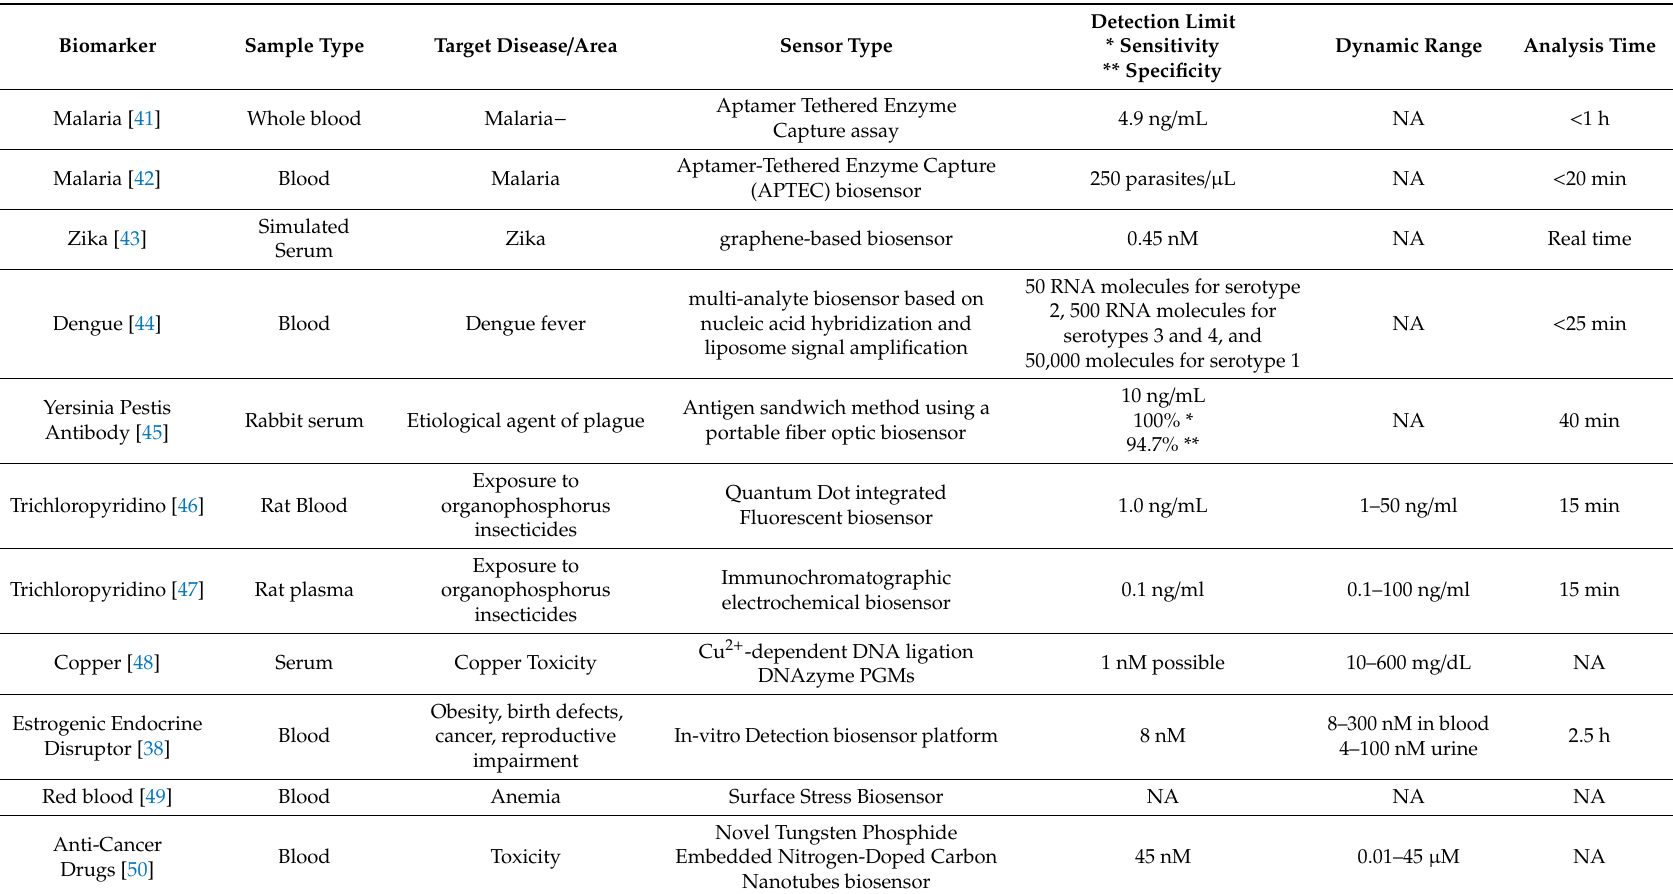
Table 4. Summary of Portable Biosensors for Blood Biomarker